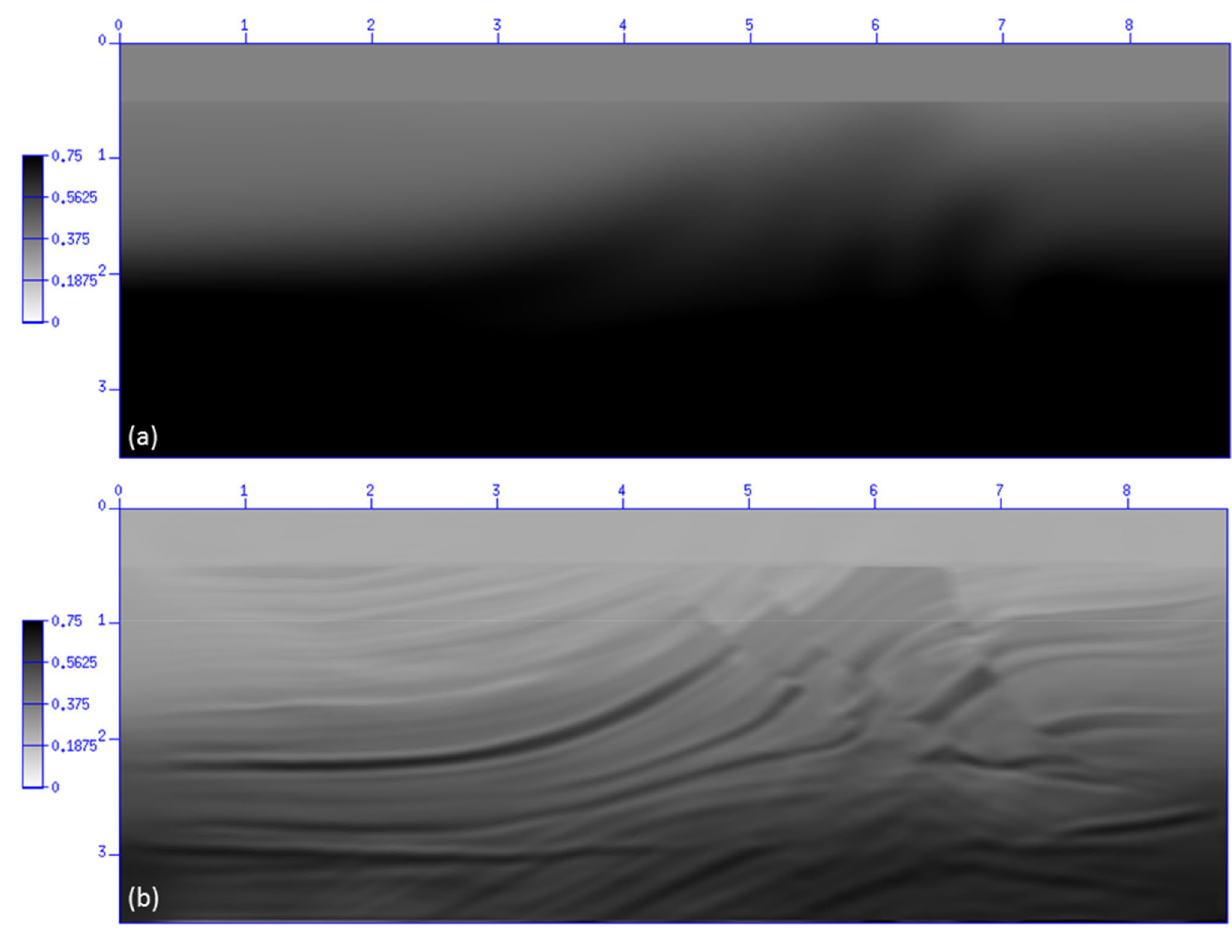
Fig. 8 Coefficient of the velocity variation a at initial b after the 200th iteration. It can be seen that the proposed coefficient captures the lateral